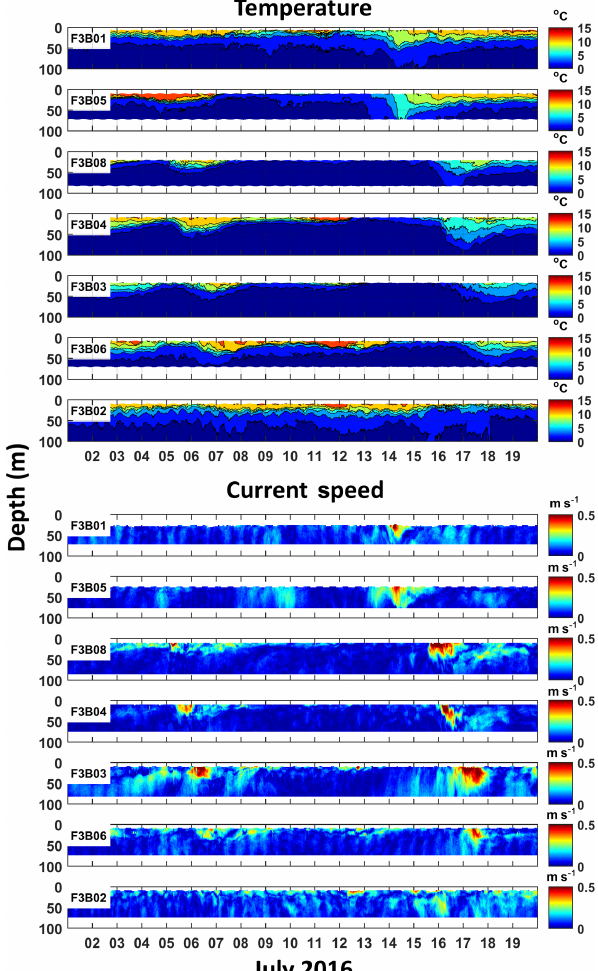
Figure 5. Fortune Bay water column thermal stratification and cur- rents from 1 to 20 July 2016 showing several upwelling and down- welling events associated with strong current “pulses” travelling around the bay, i.e. from moorings F3B01 to